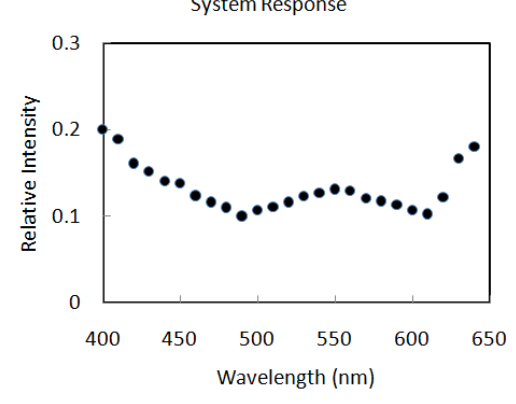
Figure 7. System response of the packaged microspectrometer. The 540 nm response has efficiency of 15%, for reference, cured SU8 transmission in the visible is above 95%.